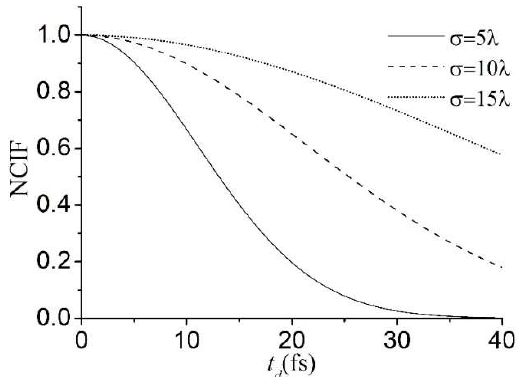
Figure 3. The normalized correlation of intensity fluctuations (NCIF) of the scattered partially coherent Gaussian Schell-model plane-wave pulse versus t d = t 2 − t 1 for different values of σ of the deterministic spherical scatterer with θ =